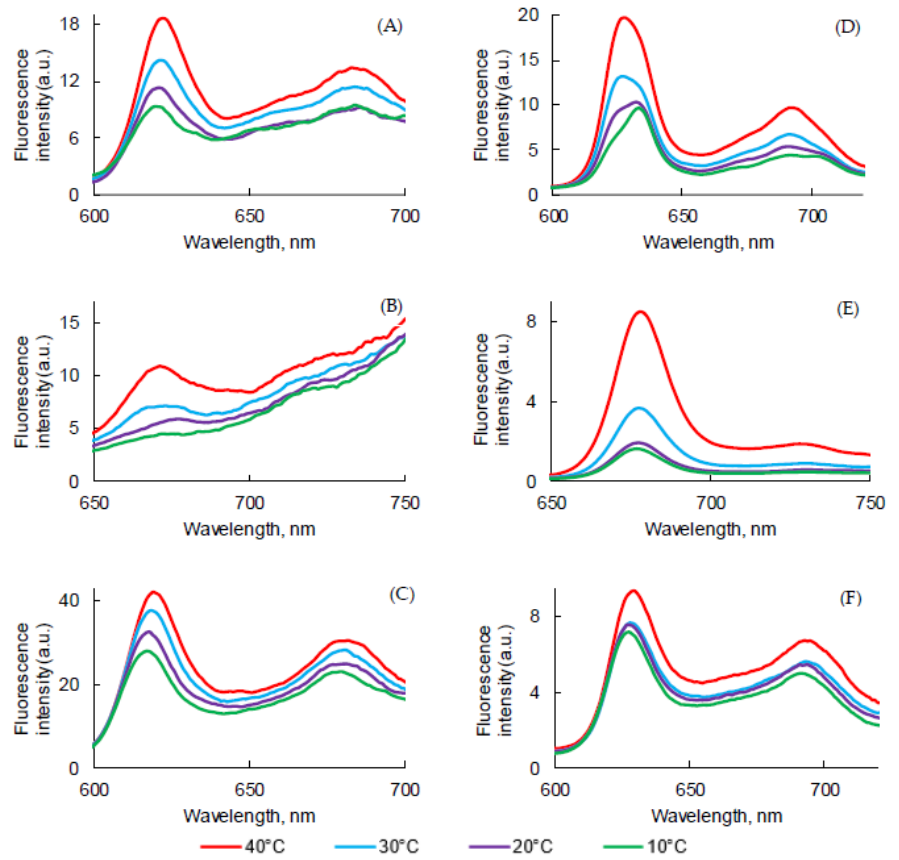
Figure 11. Fluorescence emission spectra ( λ exc = 400 nm for PpIX and PF and 415 nm for PPa) of PpIX ( A , D ), PPa ( B , E ), and PF ( C , F ) in PBS ( A – C ) and FBS ( D – F ) at different temperatures ( c = 3.1 µ M). Table 9. Fluorescence lifetimes of PpIX, PPa, and PF ( λ exc = 408 nm, c = 3.1 µ